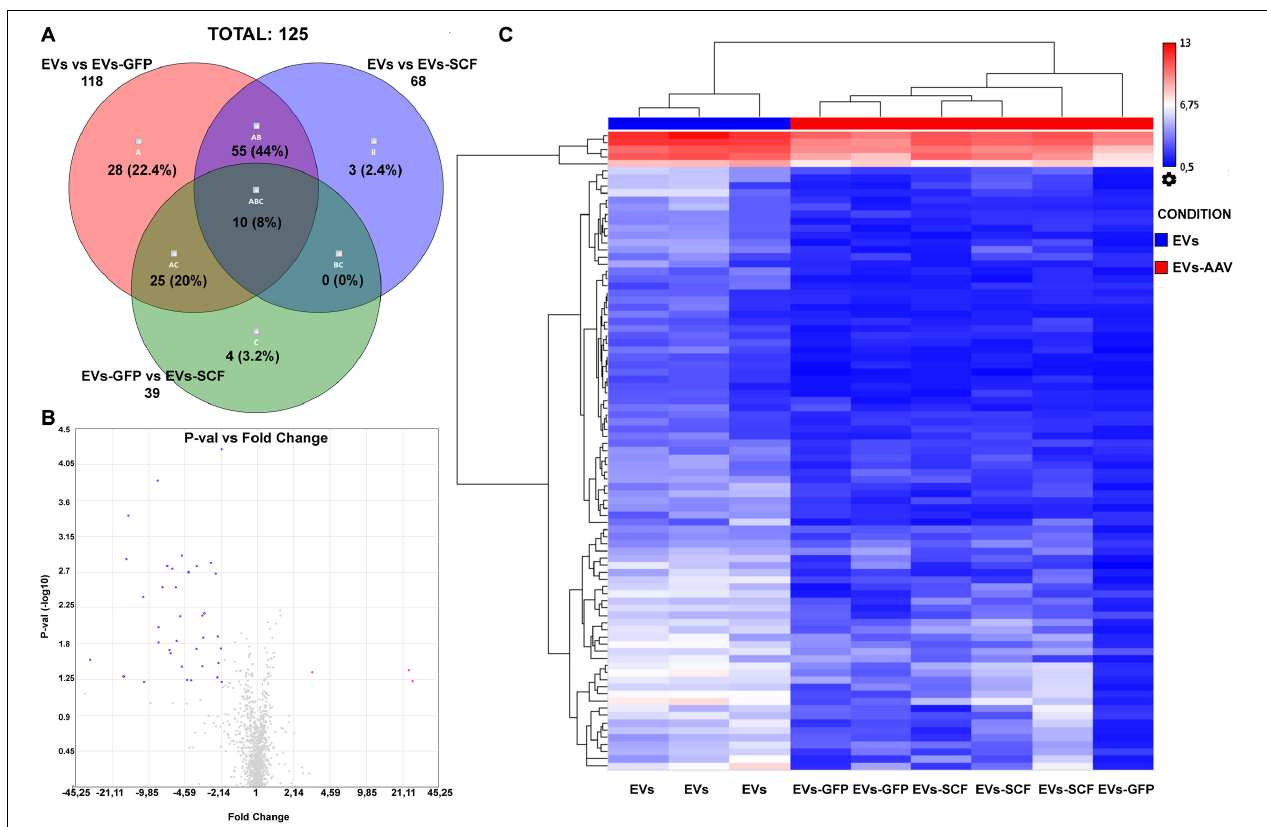
FIGURE 3 | (A) Venn diagram summarizes the number of miRNAs that are differentially expressed between EVs from stem cell factor (SCF) or green fluorescent protein (GFP)-transduced MSCs or collected from intact cells. (B) Volcano plot ( p -value vs. fold change (FC), FC ≤ –2 and FC ≥ 2) of EV miRNA from GFP-transduced MSC over EVs from SCF-transduced MSCs. Upregulated (red) and downregulated (blue) miRNA with twofold change are shown; the plot was generated using the TAC 4.0 software (Thermo Fisher Scientific, United States). (C) Hierarchical clustering of miRNA (two-way ANOVA, p -value < 0.05) from EV samples (from intact or AAV-infected MSCs). MiRNA levels are shown as a heat map. Complete-linkage clustering